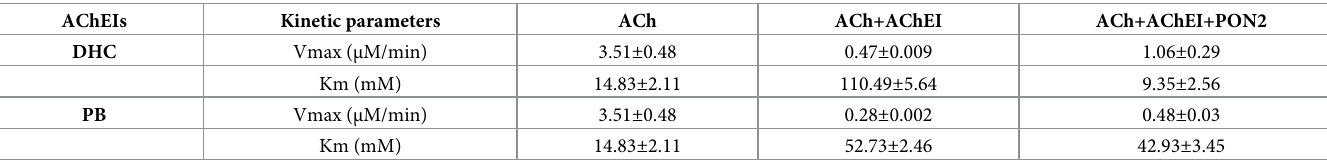
efficient in inhibiting the drug in these cases. Both the mutants showed almost a similar increase in esterase activity. However, the trend in lactonase activity did not seem to corre- spond with the trend in AChEI inhibition. Both the drugs are almost equally inhibited by the mutants. Enzyme kinetics to detect AChE inhibition by Donepezil hydrochloride and Pyridostigmine bromide in the presence of HuPON2-WT AChE enzyme kinetics was performed with the HuPON2-WT protein. Vmax and Km were calculated respectively and summarized in Table 1. Since arylesterase activity of HuPON2 is responsible for the hydrolysis of AChEIs, enzyme kinetics was performed for HuPON2-WT and all four mutants with Phenylacetate. Vmax and Km values for the WT and mutant PON2 are summarized in Table 2. Vmax of AChE in the absence of both AChEI and HuPON2 was the highest, whereas that with only AChEI was the lowest for both the inhibitors. Km values Table 1. AChE enzyme kinetics. AChEIs Kinetic